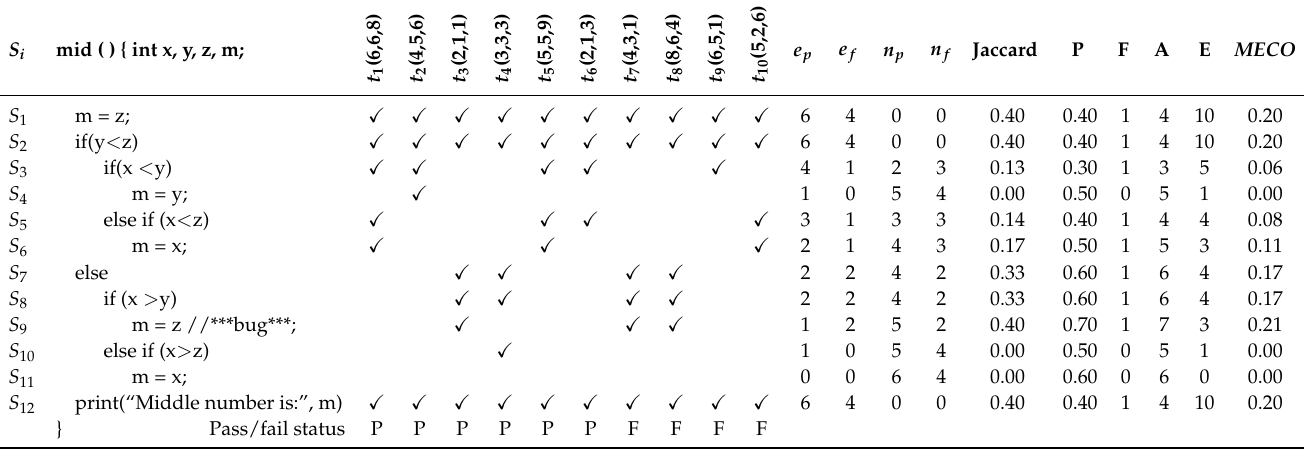
Table 2. Motivating example: fault, m 9 : m = y . P: Assumption Proportion , F: Failed Execution Flag ,